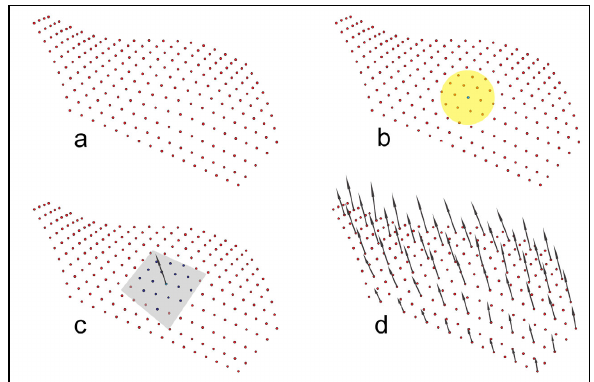
Figure 8. Initial point cloud (a); neighbours found with distance thresholding (b); fitted plane, its normal given to the point (c); procedure repeated for all points of the cloud (d).